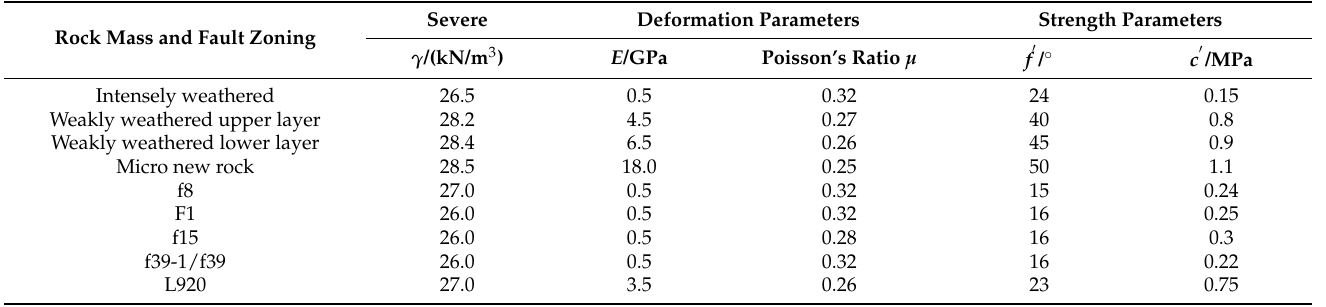
Table 1. Strength parameters of slope